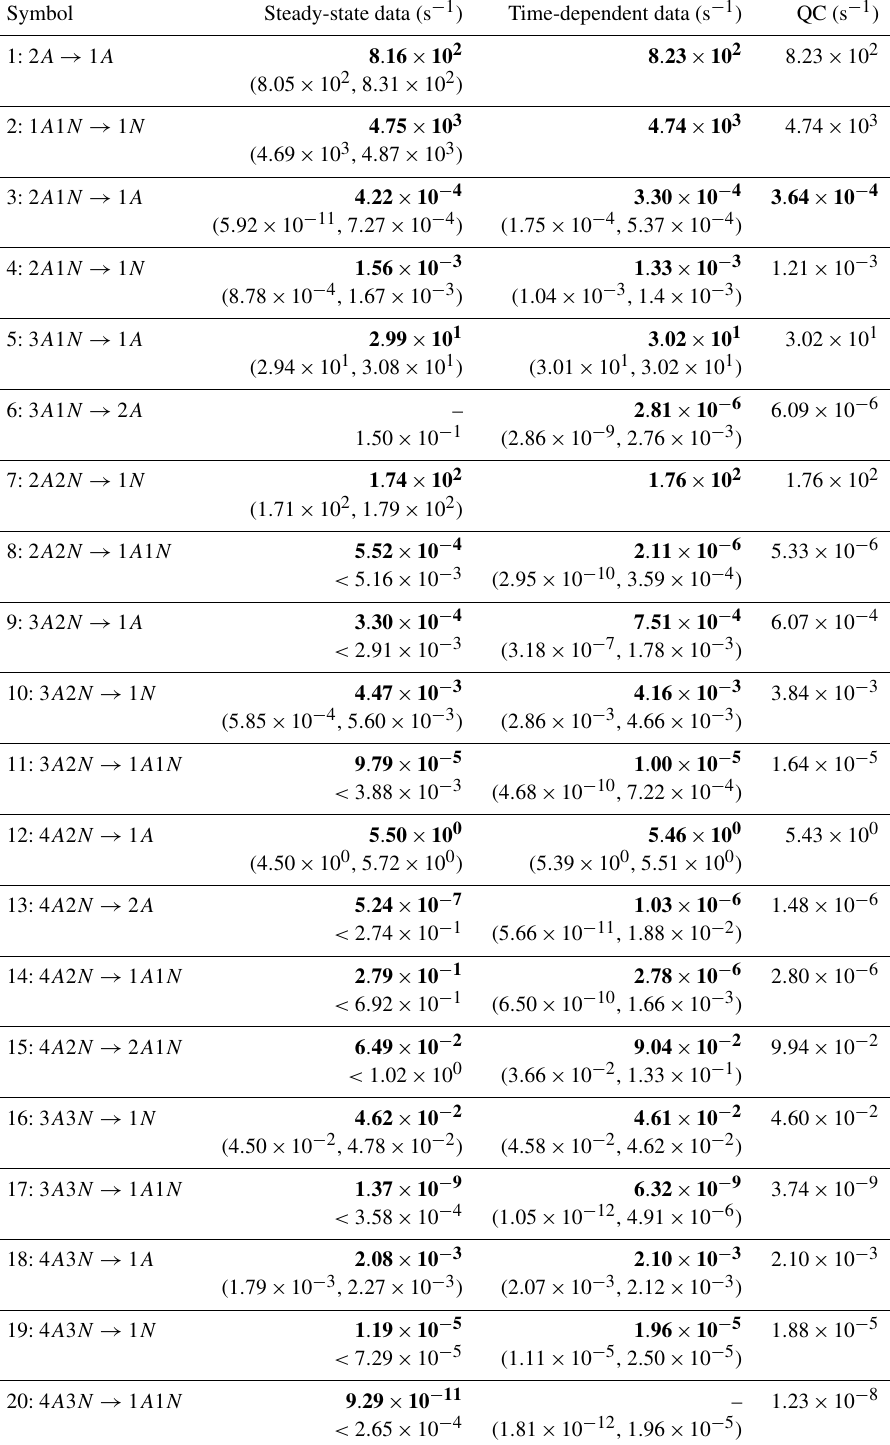
Table C1. Evaporation rates (units given in s − 1 ) determined from the steady-state and the time-dependent data presented in Figs. 5, 6, 16 and 17, respectively. For parameters that have a posterior distribution with the clear peak and practically zero probability density elsewhere, the mode of the distribution (in bold) is given together with the range of possible values in the parentheses. In some of the cases, only the limits can be determined. The last column presents the baseline values from Olenius et al. (2013b) used to generate the synthetic data. The notation xAyN corresponds to a cluster with x sulfuric acid and y ammonia